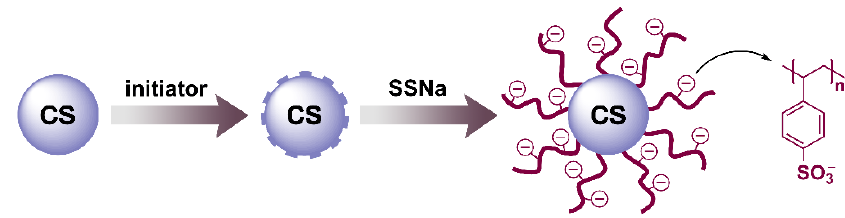
Figure 1. Synthesis process of the anionic spherical polyelectrolyte brushes (ASPB).